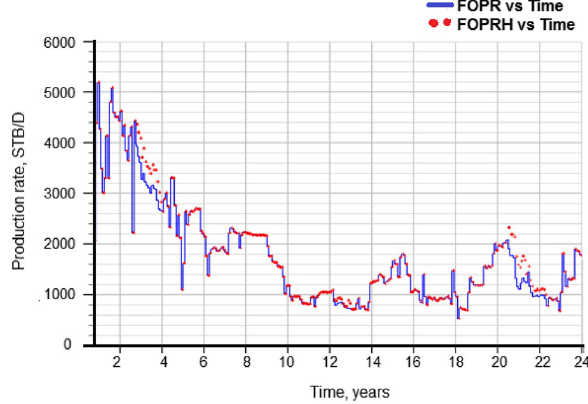
Fig. 4 Production history match of the S3